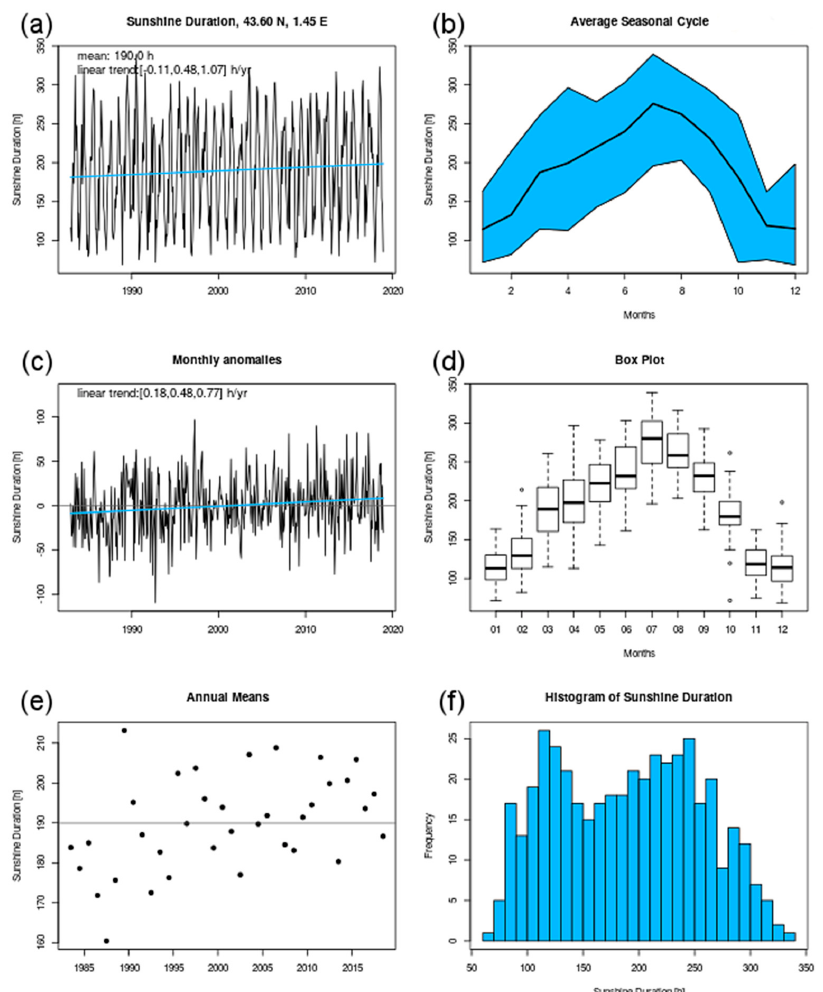
Figure 8. Analysis plots for the SDU time series for Toulouse (43.6 ◦ N; 1.45 ◦ E) from 1983 to 2018. Shown are the time series of monthly sums including a linear trend line ( a ); the annual cycle including maximum, minimum, and mean ( b ); the monthly anomalies including the linear trend ( c ); a box plot of the annual cycle ( d ); the annual monthly means including the overall mean ( e ); and the SDU histogram ( f ). The 2018 SDU monthly means for Berlin (Figure 7a) were very high, with values up to 350.8 h in